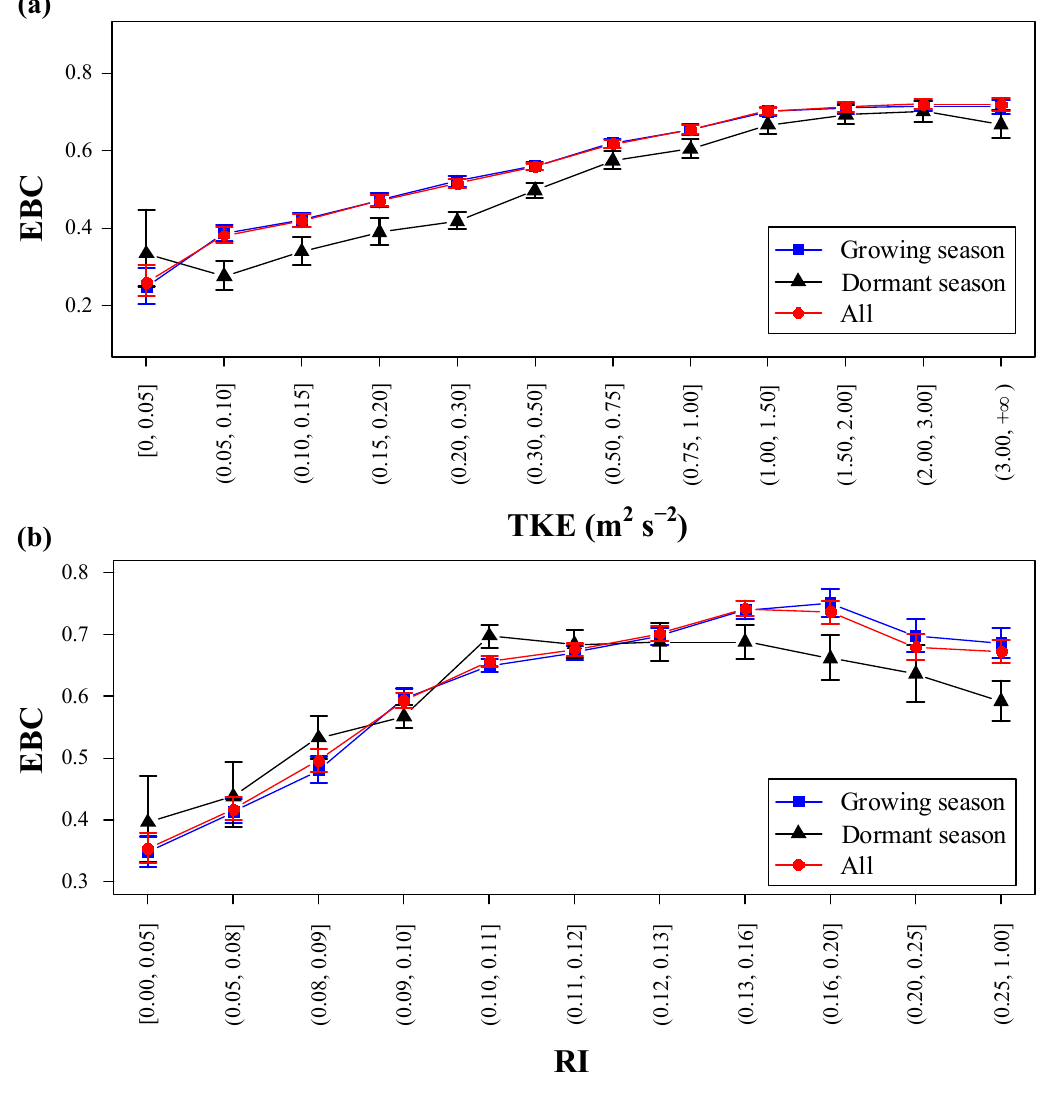
Figure 13. Average EBC for each bin of ( a ) turbulent kinetic energy (TKE), and ( b ) relative vertical turbulence intensity (RI).